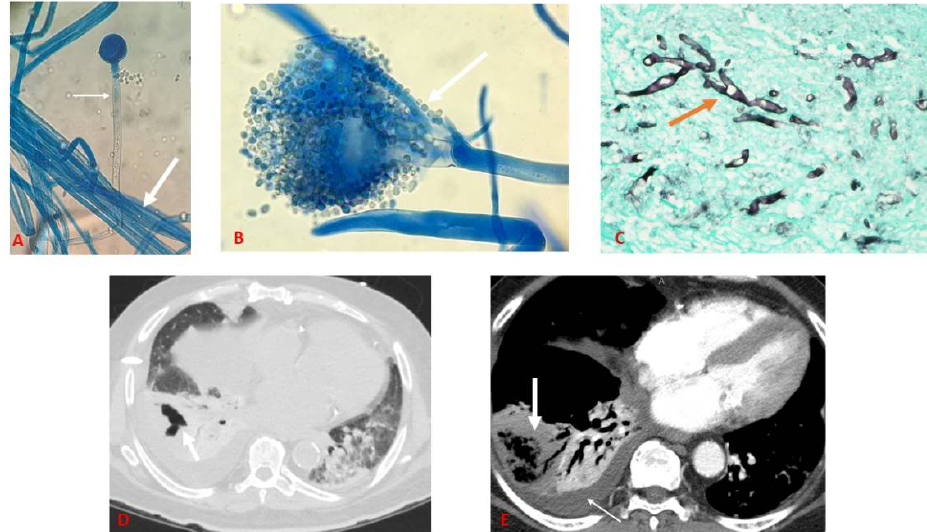
Figure 2. ( A ) Pleural fluid culture growing multiple pauci-septate hyphae (thick arrow) with a sporangiophore in focus at 10 × (thin arrow); ( B ) Pleural fluid culture with a sporangium containing multiple round sporangiospores in 40 × (thick arrow); ( C ) Pleural decortication specimen stained with GMS stain under 40 × magnification showing purulent exudate admixed with fungal organisms (orange arrow); ( D ) Computed tomography of chest with axial view showing cavity (thick arrow) in lung window; ( E ) Computed tomography angiogram of chest with axial view showing lung necrosis (thick arrow) and pleural effusion (thin